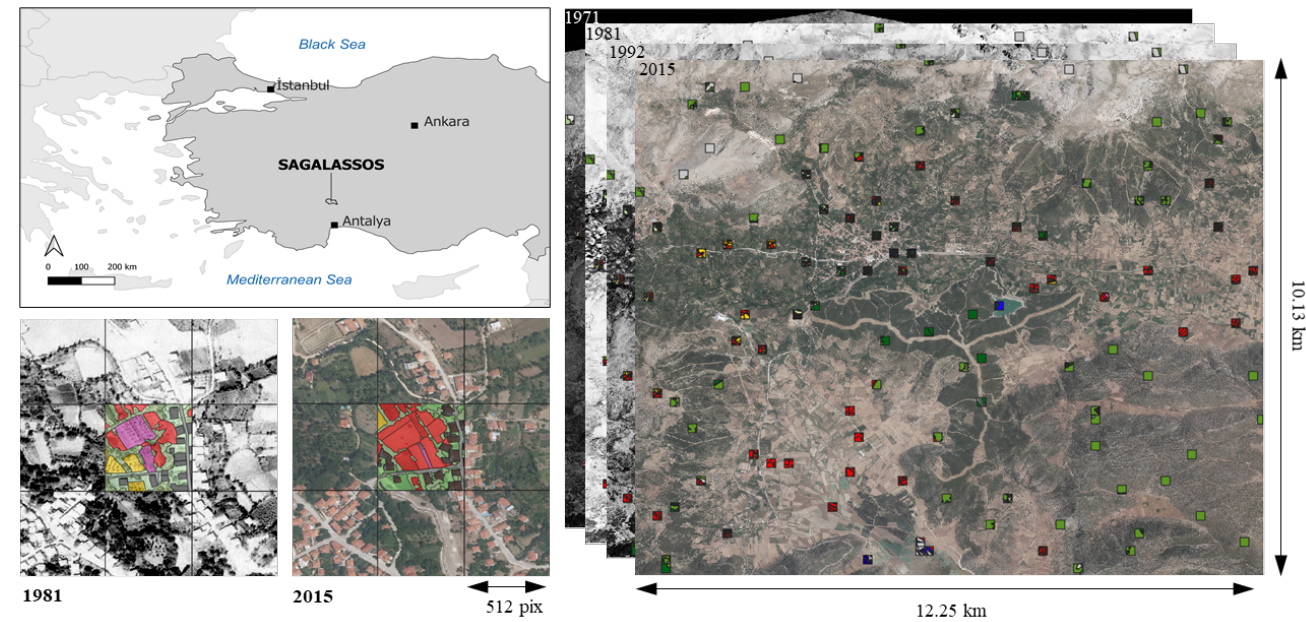
Figure 1. ( top-left ) The Sagalassos archaeological site located in the southwest of Turkey; ( right ) the study area under consideration with indication of the sample locations; ( bottom-left ) example of an annotated patch at the same geographical location on the 1981 and 2015 orthophoto.